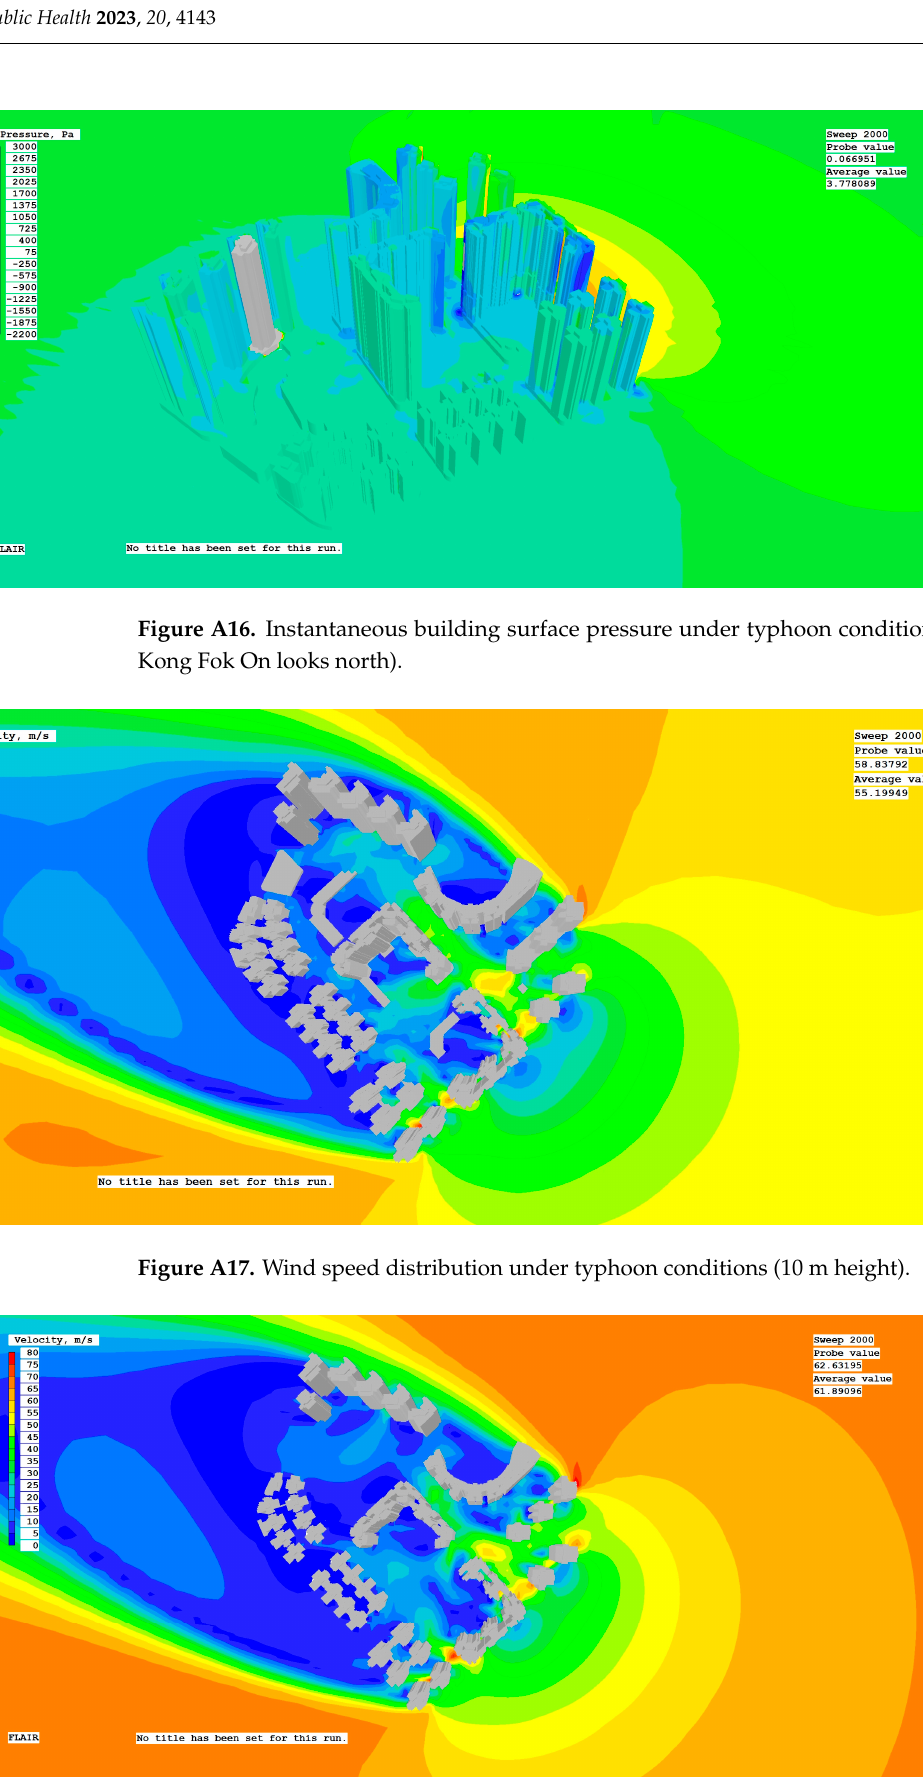
Figure A18. Wind speed distribution under typhoon conditions (50 m height).